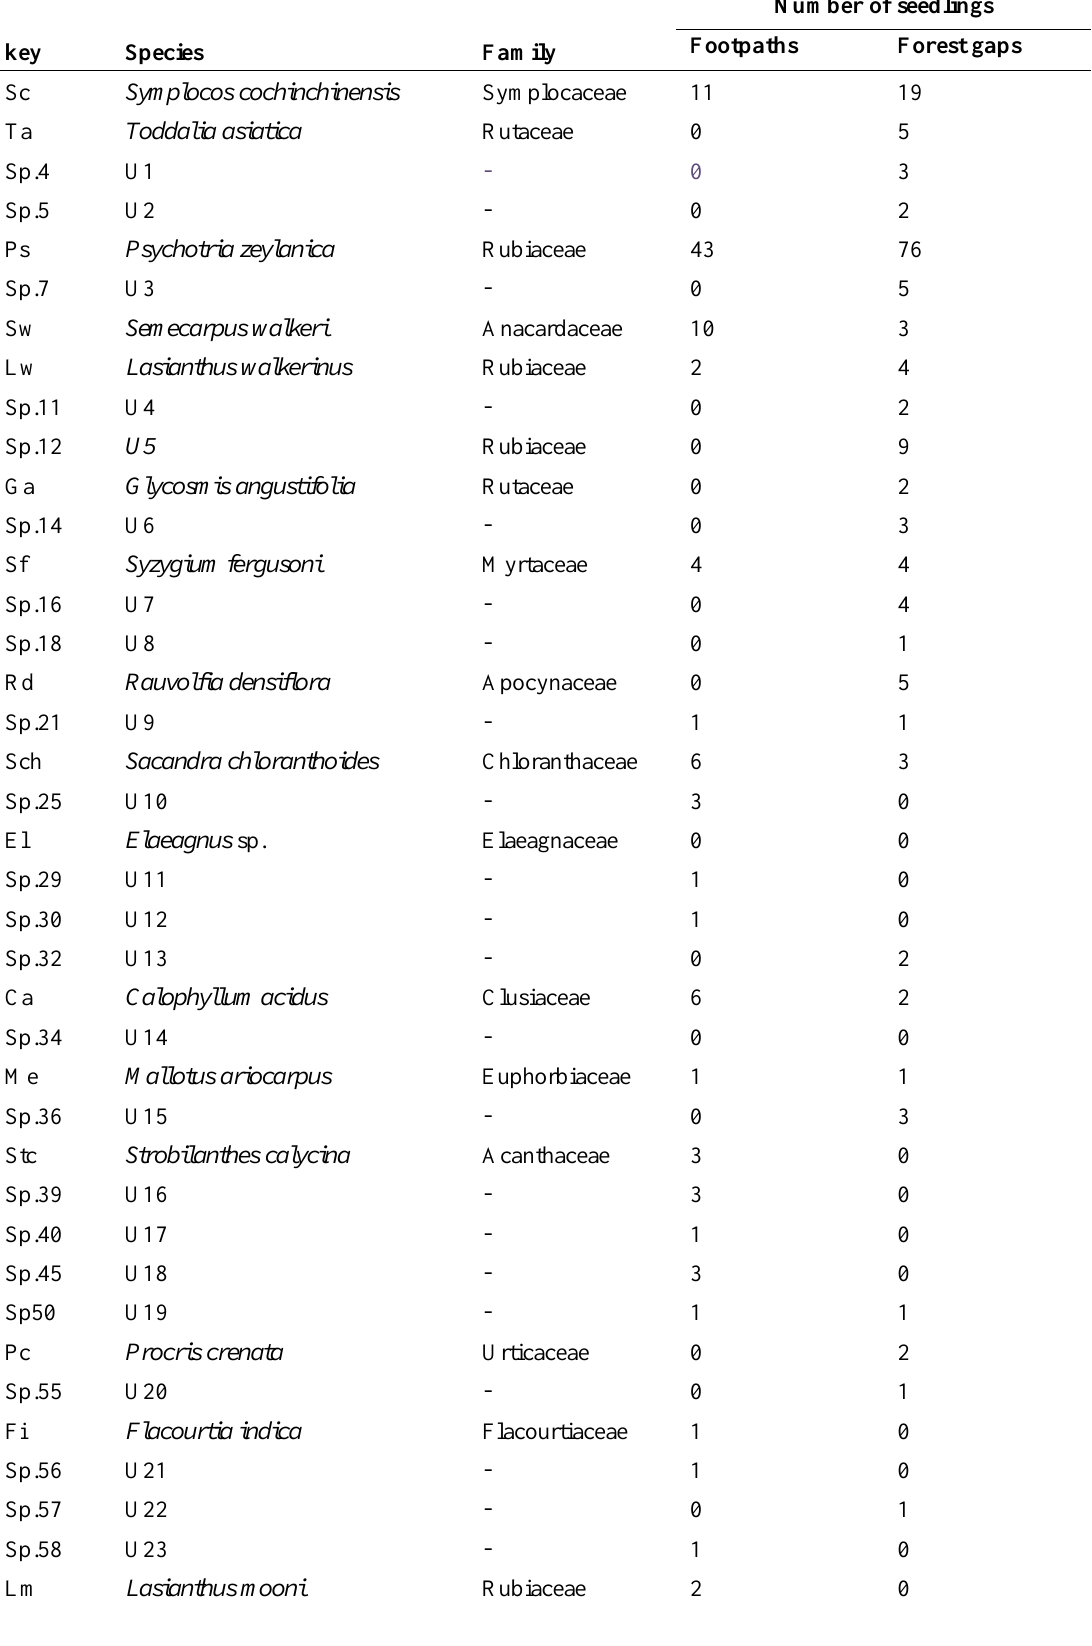
Table 1: The species recorded at the study